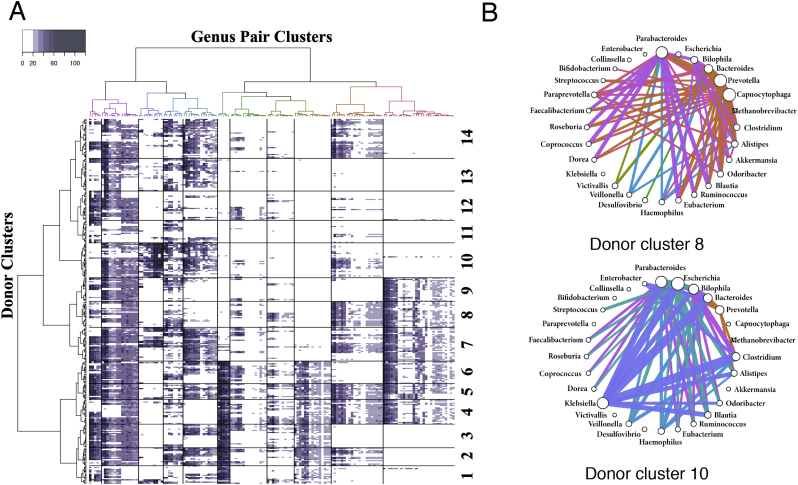
Interaction networks in the human gut microbiome data. (A) Donor groups differently characterized by common genus pairs were subjected to hierarchical clustering. Each genus cluster is colored. Genus pairs common to almost all donors were excluded from the clustering shown in Fig. S1. (B) Each donor cluster displayed specific interaction networks at the genus level. Donor clusters 8 and 10 are shown as prototype donor clusters in Fig. 5A. The colored edge represents a genus pair cluster (colored as in Fig. 5A), and the width represents the average score of the genus pair (an edge with <15 is not displayed). The size of a circle of the genus represents the total scores of the related genus pairs.